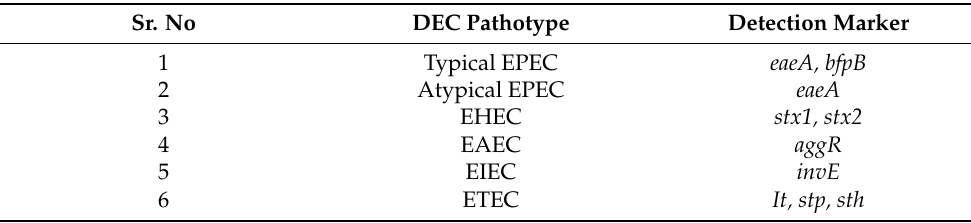
Table 1. Table representing the DEC pathotypes along with their detection marker. Sr. No